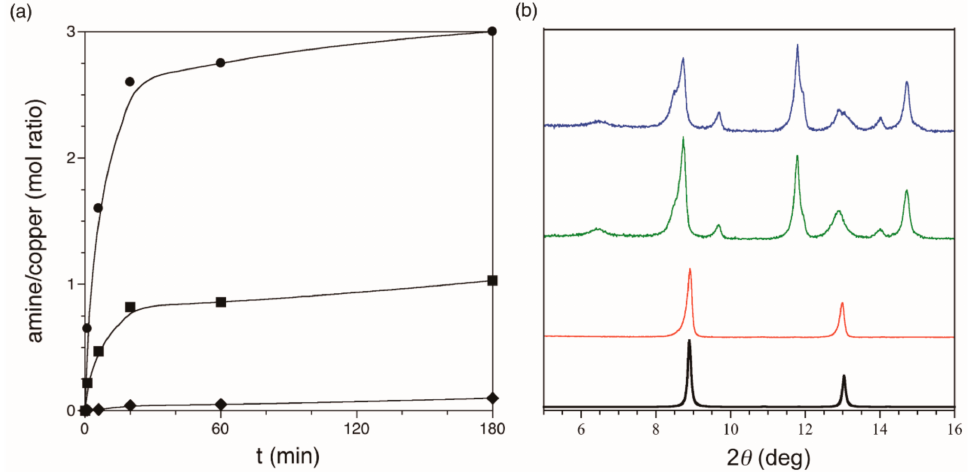
Figure 4. ( a ) Time profiles for the adsorption of MA ( • ), DMA ( (cid:4) ), and TMA ( (cid:4) ) vapors by 1 at room temperature. The solid lines are only eye-guides. ( b ) XRPD of 1 (red line) and the MA adsorbates 2 (green line) and 3 (blue line). The bold black line represents the calculated XRPD of 1 from the single-crystal X-ray